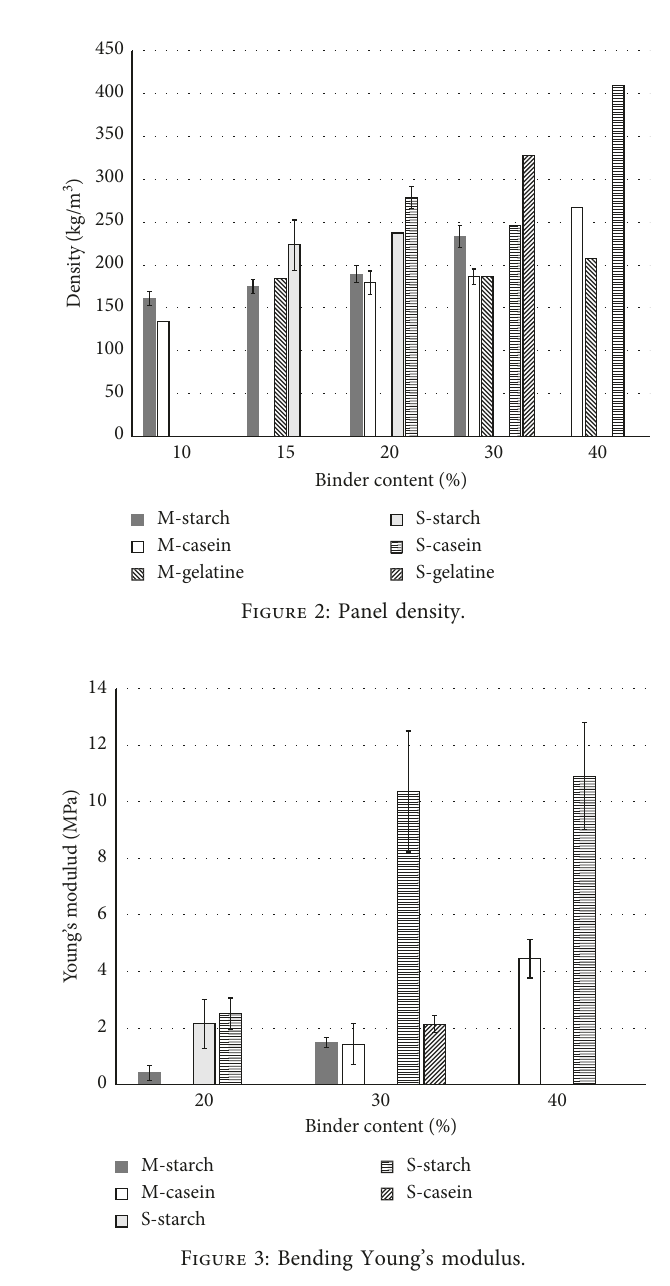
Figure 3: Bending Young’s